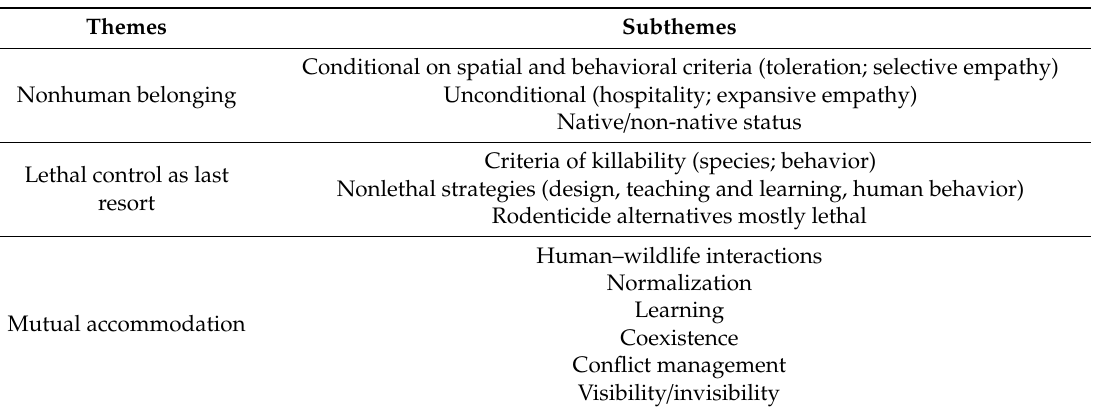
Table 1. Coexistence in urban wildlife